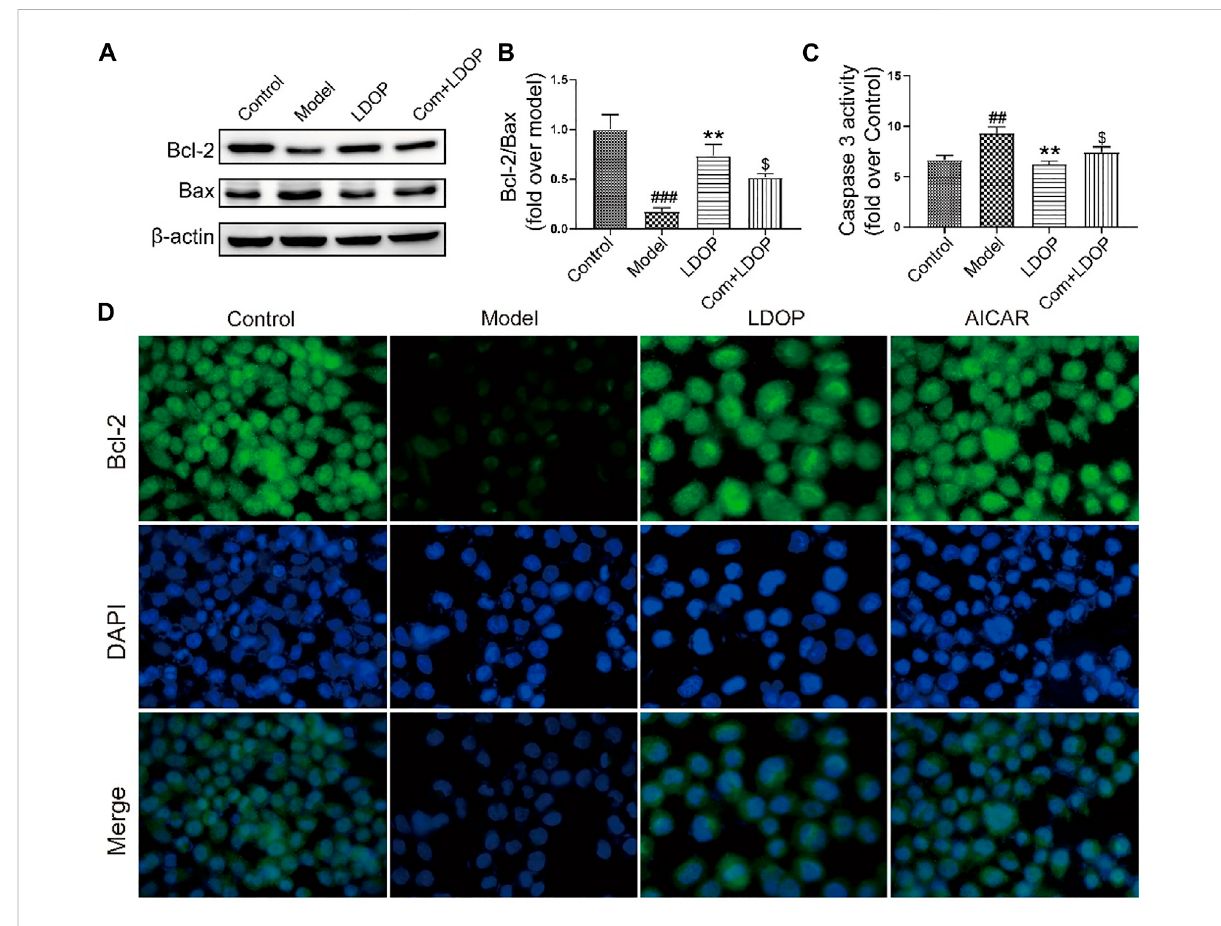
FIGURE 11 LDOP inhibited the expression of Bax, caspase 3 and boost of Bcl-2. (A) The expression of Bax and Bcl 2 detected by Western blot. (B) Statistical analysis on ratio of Bax to Bcl-2. (C) The production of caspase 3 detected by biochemical markers kit. (D) Immunohistochemical image of Bcl